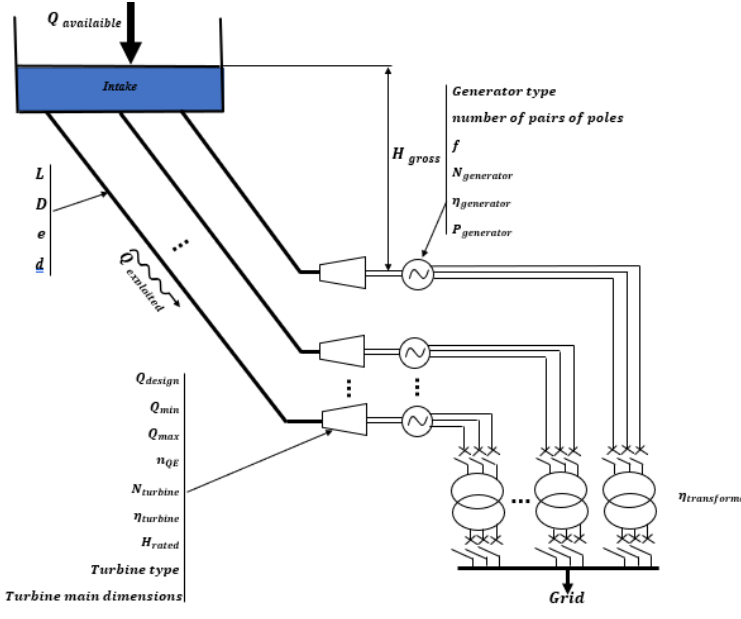
Figure 5. Schematic plant layout and parameters for optimization.